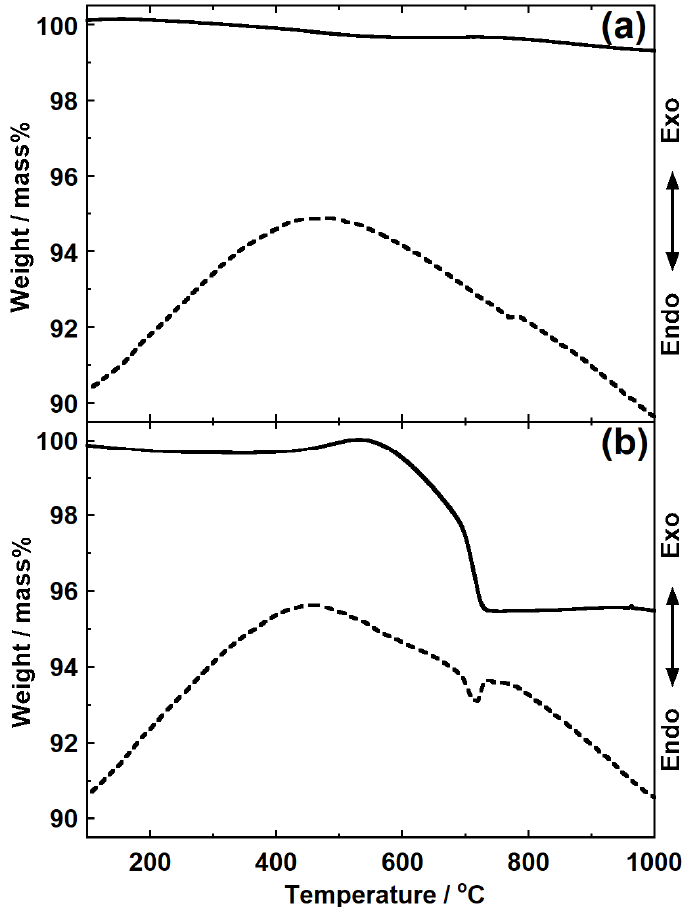
Figure 3. Thermogravimetric–differential thermal analysis (TG–DTA) profiles of samples obtained using ( a ) the spent autocatalyst alone and ( b ) the spent autocatalyst with Li 2 CO 3 . Solid lines: TG curves; dashed lines: DTA curves.